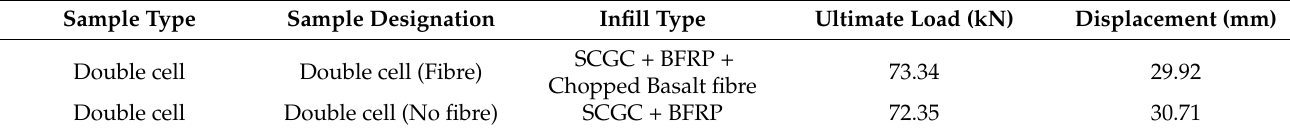
Figure 6. Load vs. displacement of double-cell infill panels. Table 4. Results of double-cell composite slabs.